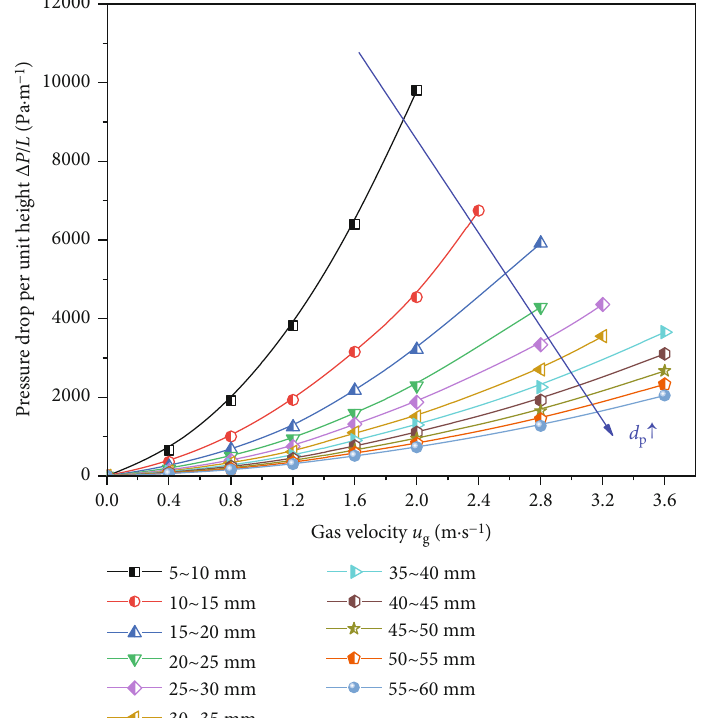
Figure 7: The variation of the pressure drop of the gas fl ow per unit height ( Δ P / L ) vs. the gas velocity ( u